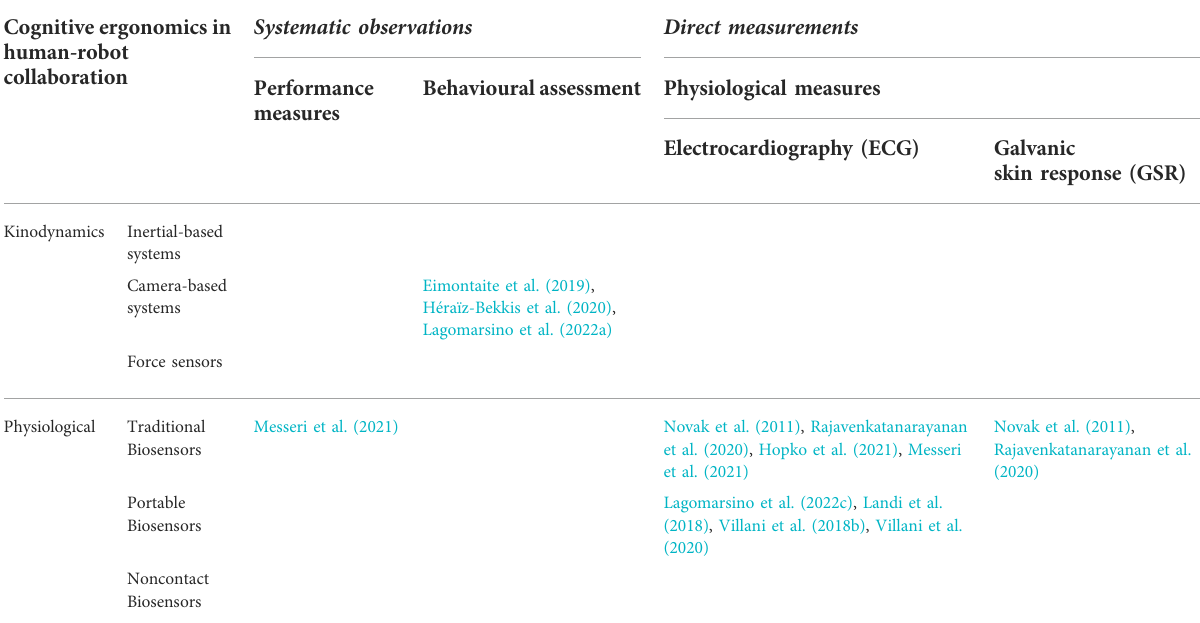
TABLE 2 Cognitive ergonomics in industrial HRC: distribution of works among main monitoring systems and ergonomic assessment techniques. Cognitive ergonomics in human-robot